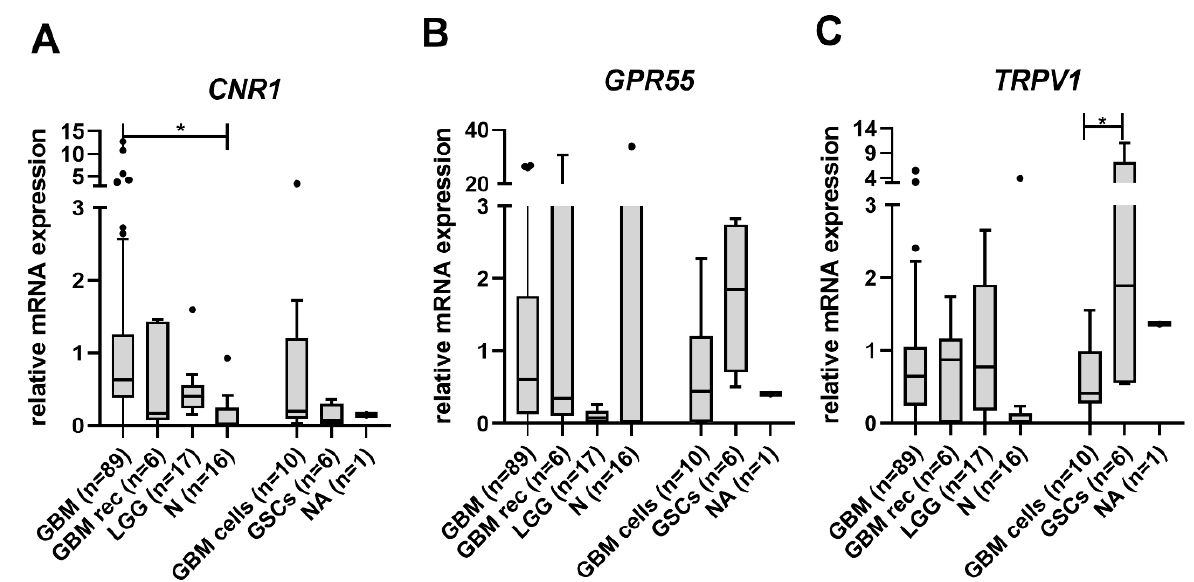
Figure 1. Receptor mRNA levels in different types and grades of glioma samples. The expression of ( A ) CNR1 (CB1), ( B ) GPR55 , and ( C ) TRPV1 in glioma, non-cancerous brain tissues, and GBM cells. mRNA values were normalized to the housekeeping genes HPRT1 and GAPDH and analysed with quantGenius software (developed at NIB). n : number of samples; N : non-cancerous brain tissues; LGG: grade I or II gliomas (pilocytic astrocytoma, astrocytoma, oligodendroglioma); GBM: glioblastoma; GBM rec: recurrent glioblastoma; GBM cells: primary glioblastoma cells; GSCs: glioblastoma stem cells isolated from patient tumour samples; NA: normal astrocytes versus N: the non-cancerous brain tissues (* p < 0.05).